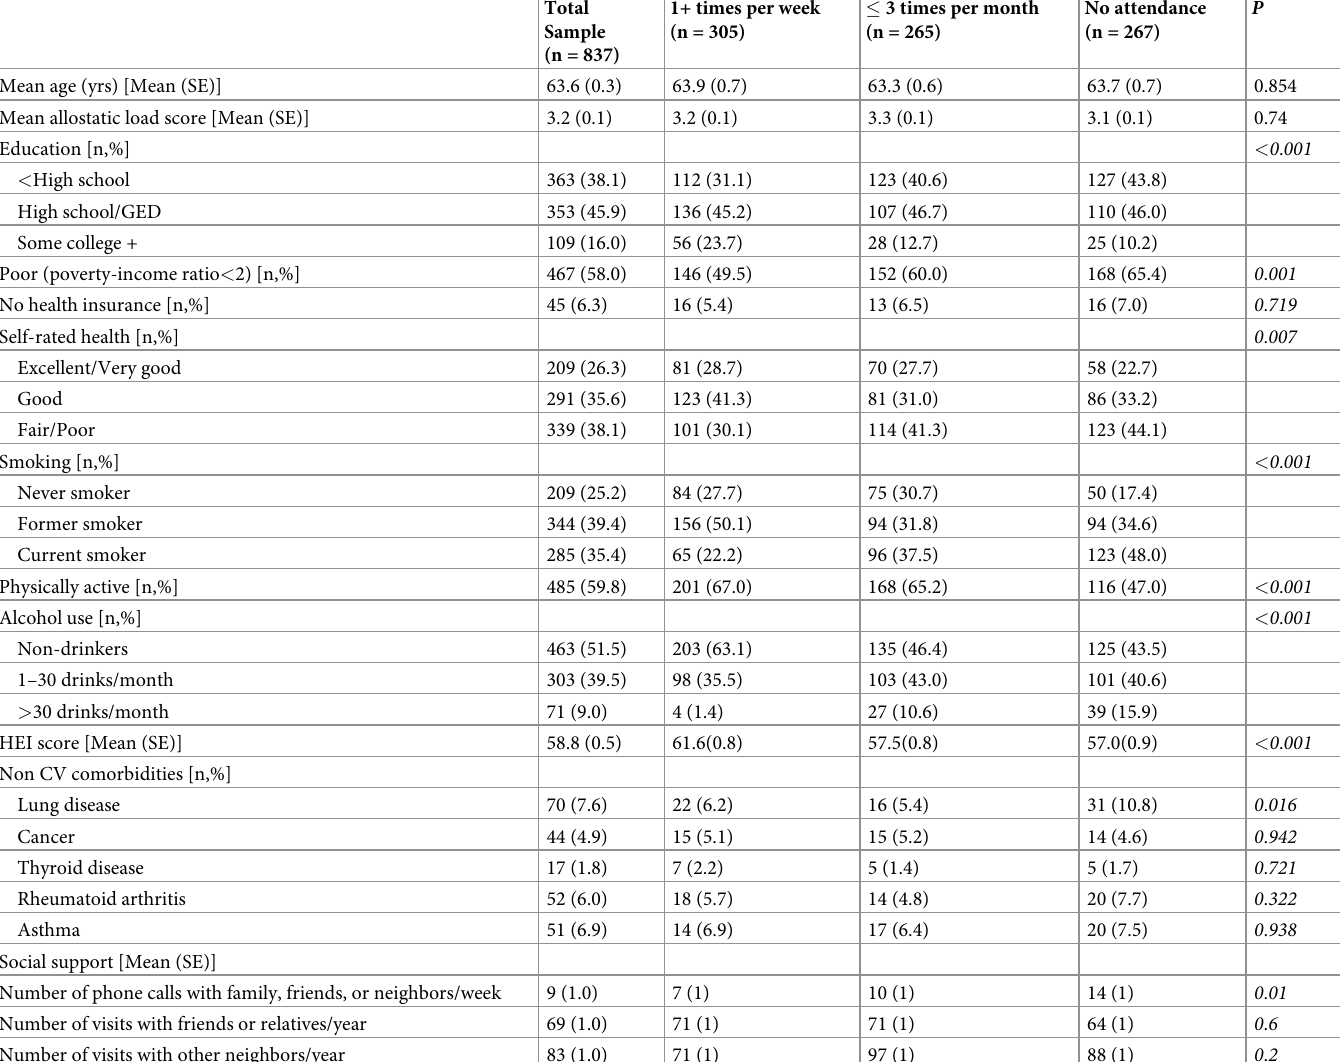
Table 1. Baseline characteristics of Black Men 50 and older in NHANES III by self-reported religious service